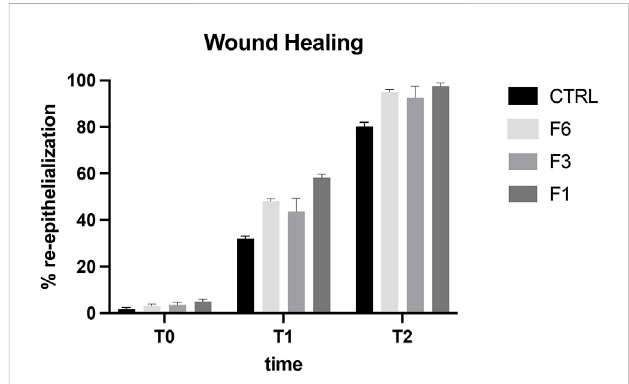
FIGURE 3 Wound healing in rabbit eye. T0 (day 1), T1 (day 2), T2 (day 4). Formulation 6 (F6); RenerviX ® (F3); Formulation 1 (F1); Control group.Dataareshowedas%ofcornealre-epithelialization.Nostatistical differences were observed between treated groups. Data are shown as mean ± SD ( n = 4).